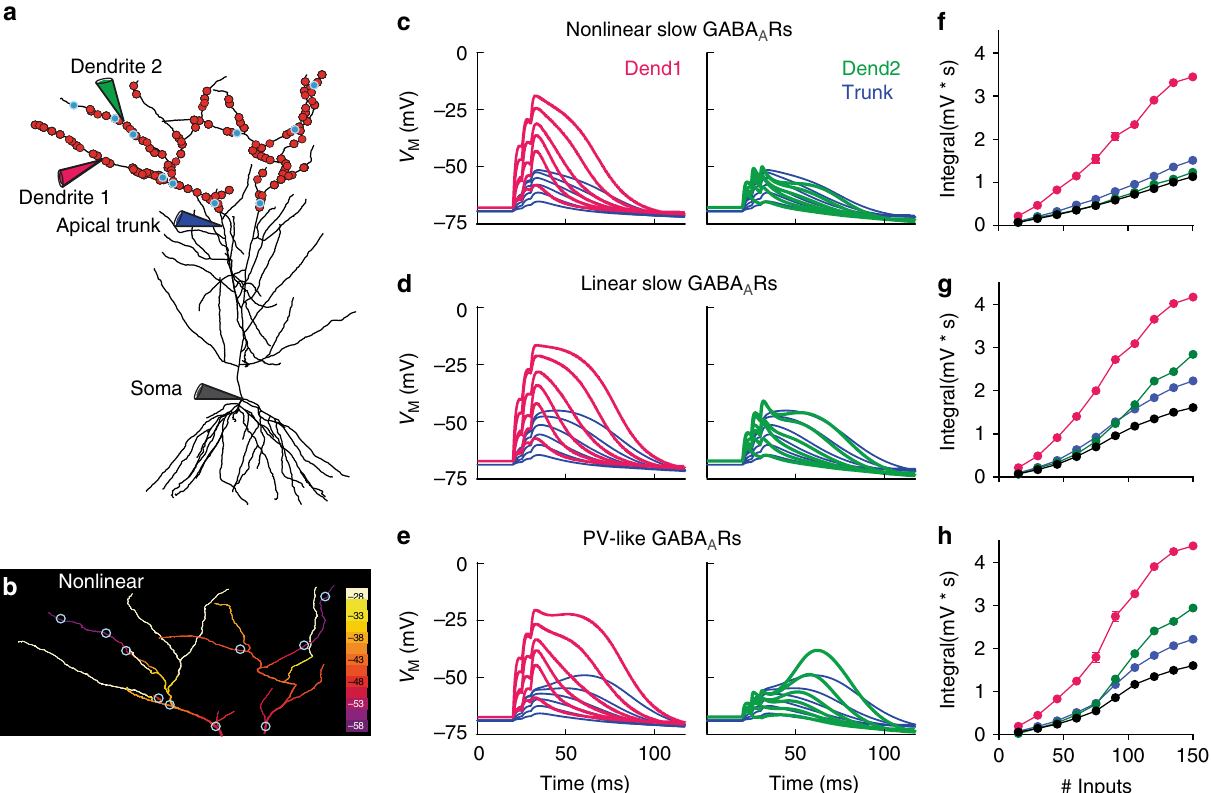
Fig. 8 SOM-interneuron-evoked nonlinear GABAergic inhibition powerfully regulates NMDAR-mediated dendritic spikes. a Computational pyramidal-cell model with stimulated glutamatergic (red) and GABAergic synapses (blue). b The local membrane potential as a result of glutamatergic and GABAergic (open circles) inputs at 20 ms after a short burst stimulation (3@200 Hz) is shown as a heat map across the tuft dendrites. c Membrane potential responses from the same simulation are shown for the left apical dendritic trunk (blue traces) and two tuft dendrites, one without inhibition (left, magenta traces) and one with strong inhibition (right, green traces). Recording sites of the local membrane potential are indicated by colored pipettes in a . The family of different voltage traces show brief-burst activation of an increasing number of glutamatergic inputs. The number of active synapses during the fi rst stimulus (15, 45, 75, 105, 135, and 165) represent about 1 – 10% of all available tuft synapses. d When the GABAR conductance is constant, membrane potential responses exhibit larger NMDAR-mediated plateau depolarizations in both the disinhibited and the inhibited tuft dendrite. e Inhibition with PV- like dynamics using 5-fold faster time course of the slow component (rise τ = 0.2 ms; decay τ = 6 ms) and 5-times larger peak conductance, fails to prevent an NMDAR-mediated dendritic spike in the inhibited tuft dendrite if the number of glutamatergic inputs exceeds 5.1% active synapses (>75 of 1464 distributed over the whole tuft). f – h The dependence of the burst PSP integral measured in the different compartments on glutamatergic input number for all three conditions. Each point is the mean of fi ve simulations with randomized glutamatergic synapse locations, while the location of GABA synapses was kept constant. The SEM is indicated. magenta: dend1; green: dend2; blue: apical trunk; black: